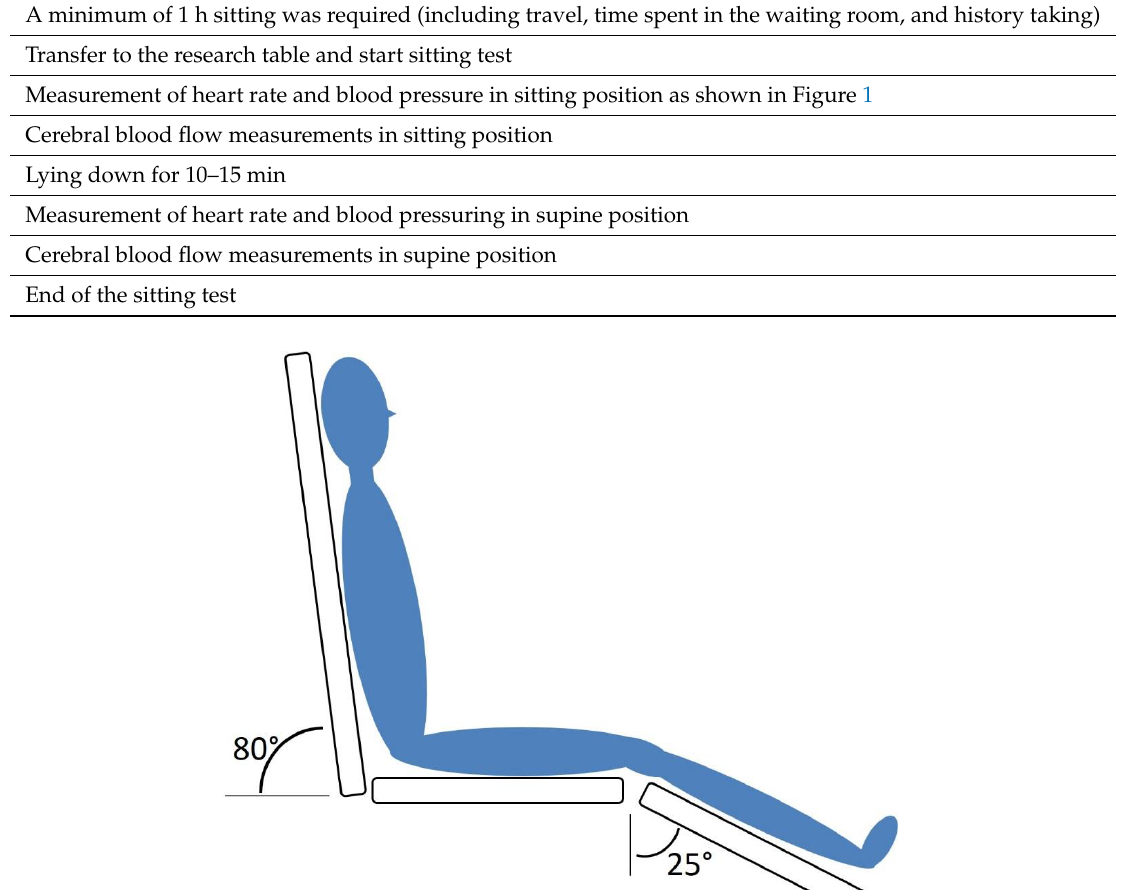
Table 1. Summary of the sitting test procedure.